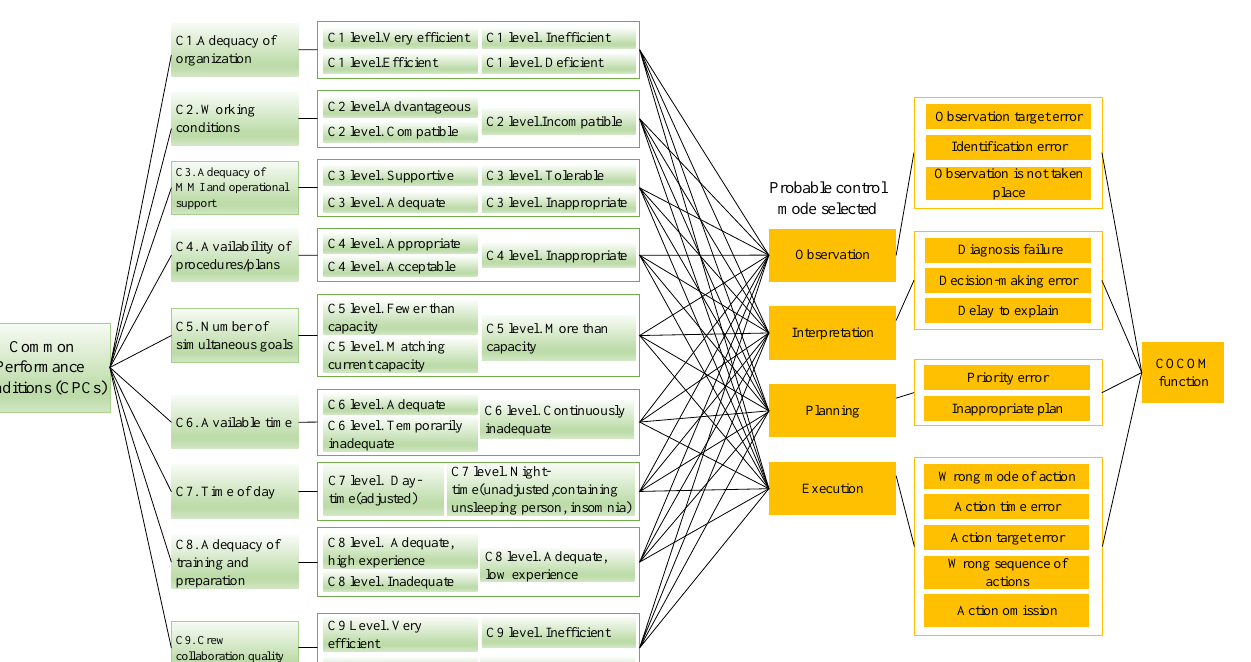
Figure 3. The flow chart of improved CREAM. 2.2.1. Assessment of Common Performance Conditions The conventional weighting value of the CPC factors of CREAM are obtained from the average of each factor. To make the assessment more reasonable and improve usa- bility, according to the circumstances and case, the weighting value of each CPC factor should be adjusted under the different application environments based on the actual equipment. The Delphi method, developed by the RAND Corporation, is applied ac- cording to actual situations to consult experts [47]. Experts ranked the importance of the factors for CPCs. Based on this adjustment, the factors for CPC coefficients provided by CREAM fall under four major cognition control modes: observation, interpretation, planning, and execution. However, experts’ experiences are subjective to a certain extent